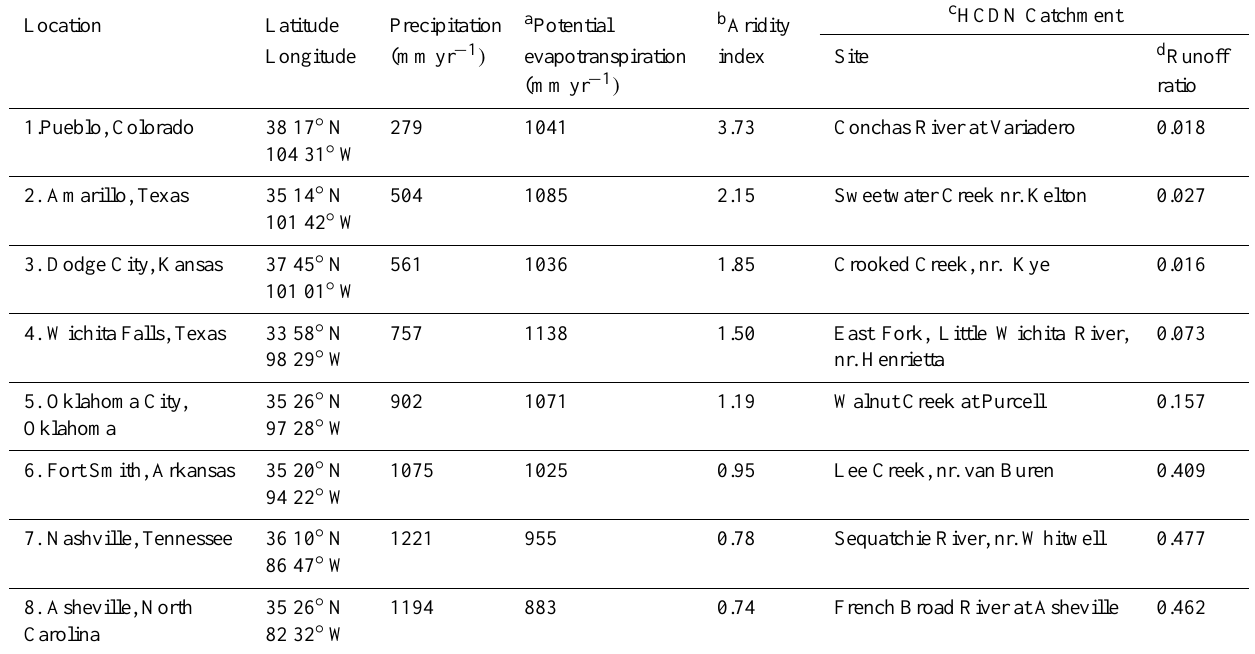
Table 2. Weather stations (SAMSON) used for driving data and nearby catchments (HCDN) with measured discharge/precipitation ratios. Location